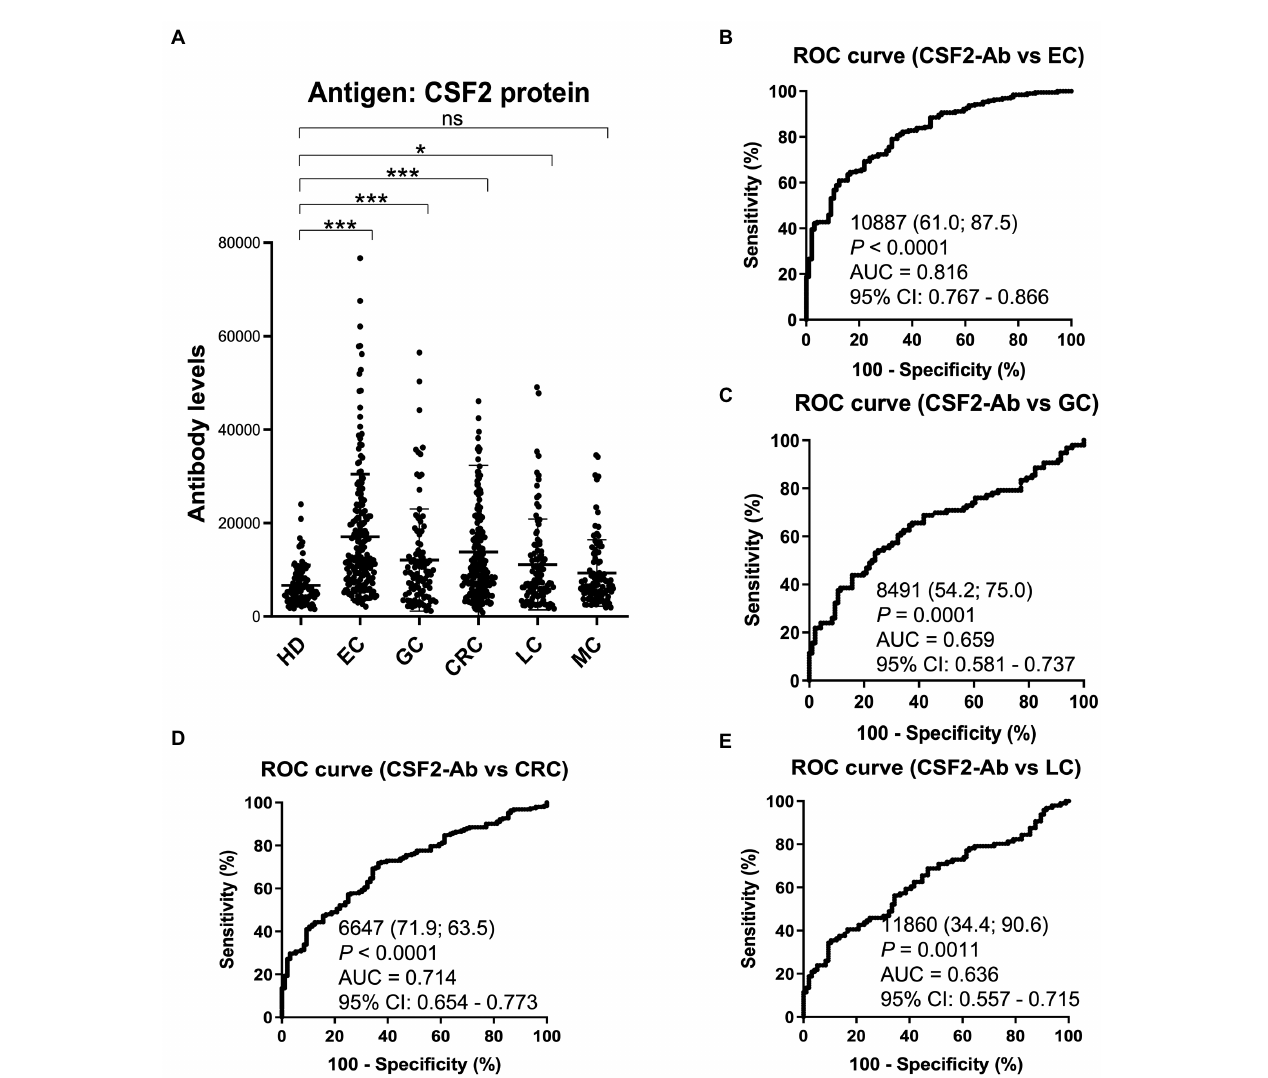
FIGURE 5 Comparison of the s-CSF2-Ab levels between HDs and patients with cancers. ( A ) Scatter dot plots of the s-CSF2-Ab levels in HDs and in patients with EC, gastric cancer (GC), CRC, lung cancer (LC), and mammary cancer (MC). The results are presented as described in the legend of Figure 2. ** P < 0.01; *** P < 0.001; ns, not significant. ROC analysis was conducted to assess the ability of s-CSF2-Abs to detect EC ( B ), GC ( C ), CRC ( D ), and LC ( E